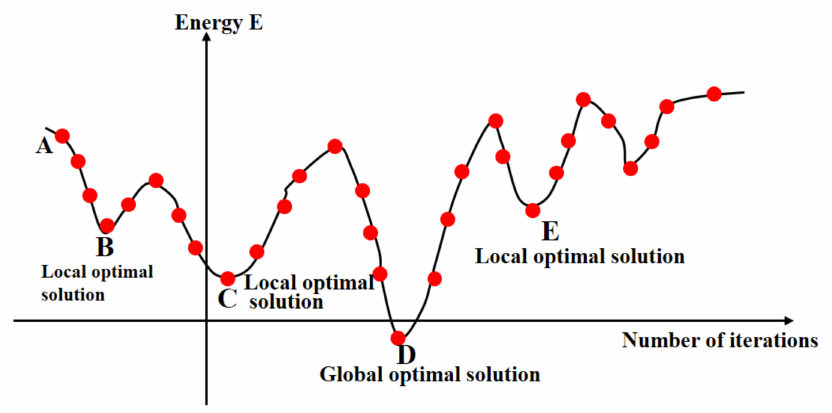
Figure 5. Schematic diagram of the annealing